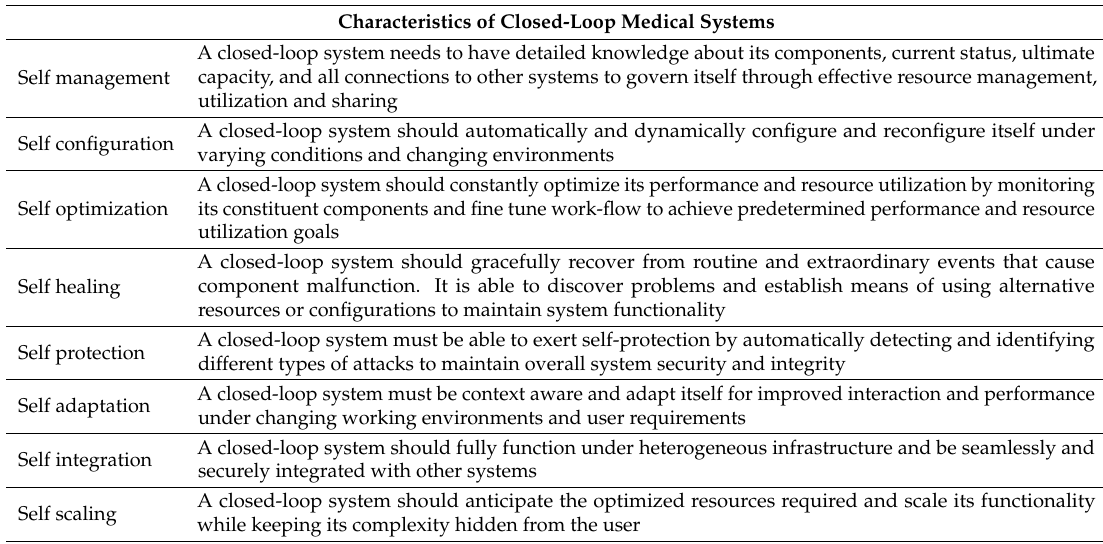
Table 2. Features of closed-loop medical systems. Inspired from